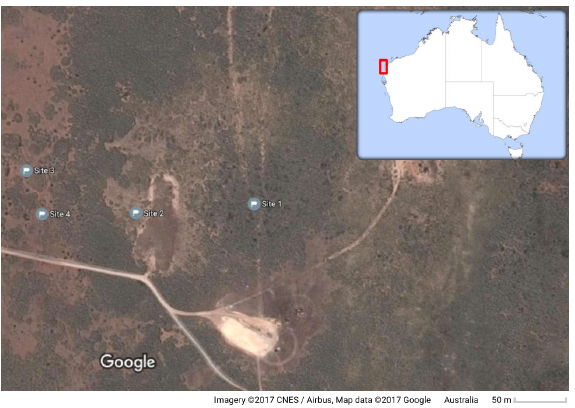
Figure 3. Primary location of the studied sites at Cape Range National Park,